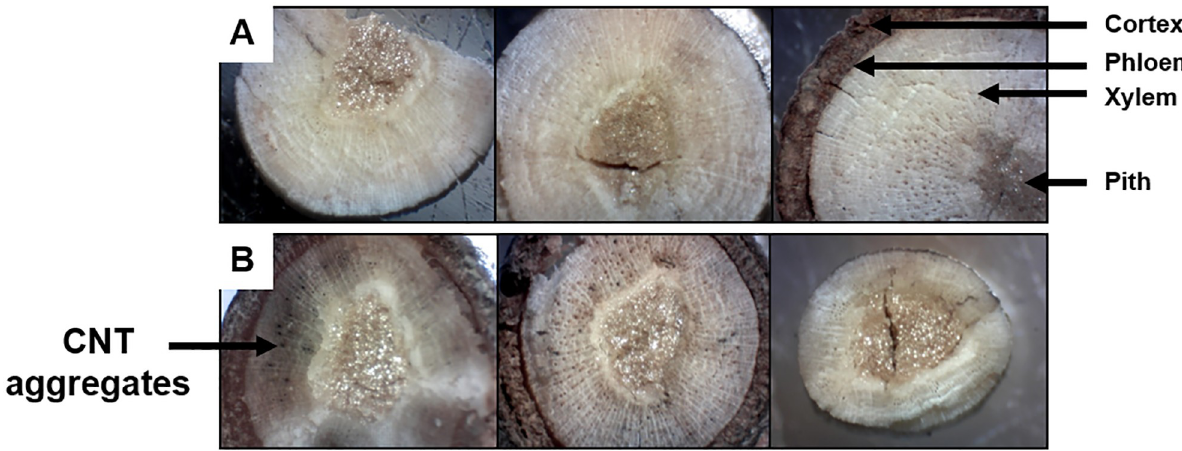
Fig 2. Microscopic inspection of carbon nanotube (CNT) transpiration in the xylem. From left to right are subsamples dissected from the proximal, central, and distal sections of the wood, respectively. (A) Scion samples treated with sterile deionized water (dH 2 O). Arrows identify the anatomical features of a transect of the scion. (B) CNT-treated scion samples. Arrow indicates the presence of aggregated CNT